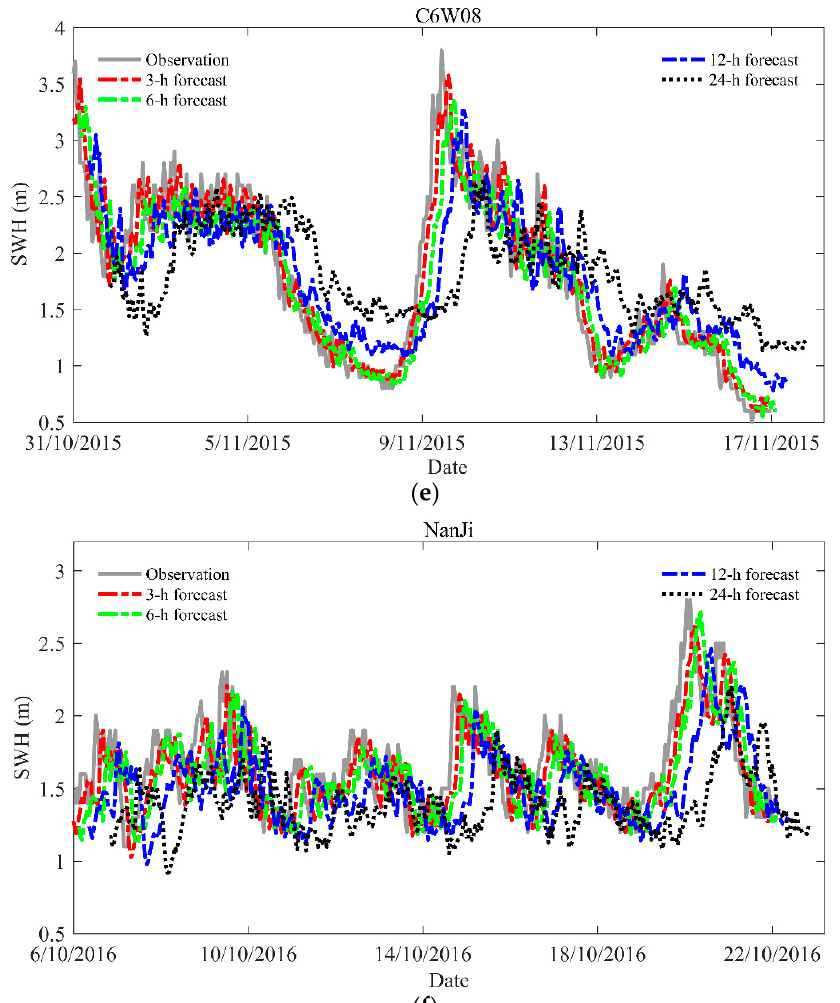
Figure 7. SWH prediction of four-time spans at six stations at various stations: ( a ) station 46714D, ( b ) station 46735A, ( c ) station 46787A, ( d ) station C6V27, ( e ) station C6W08, ( f ) station NanJi.